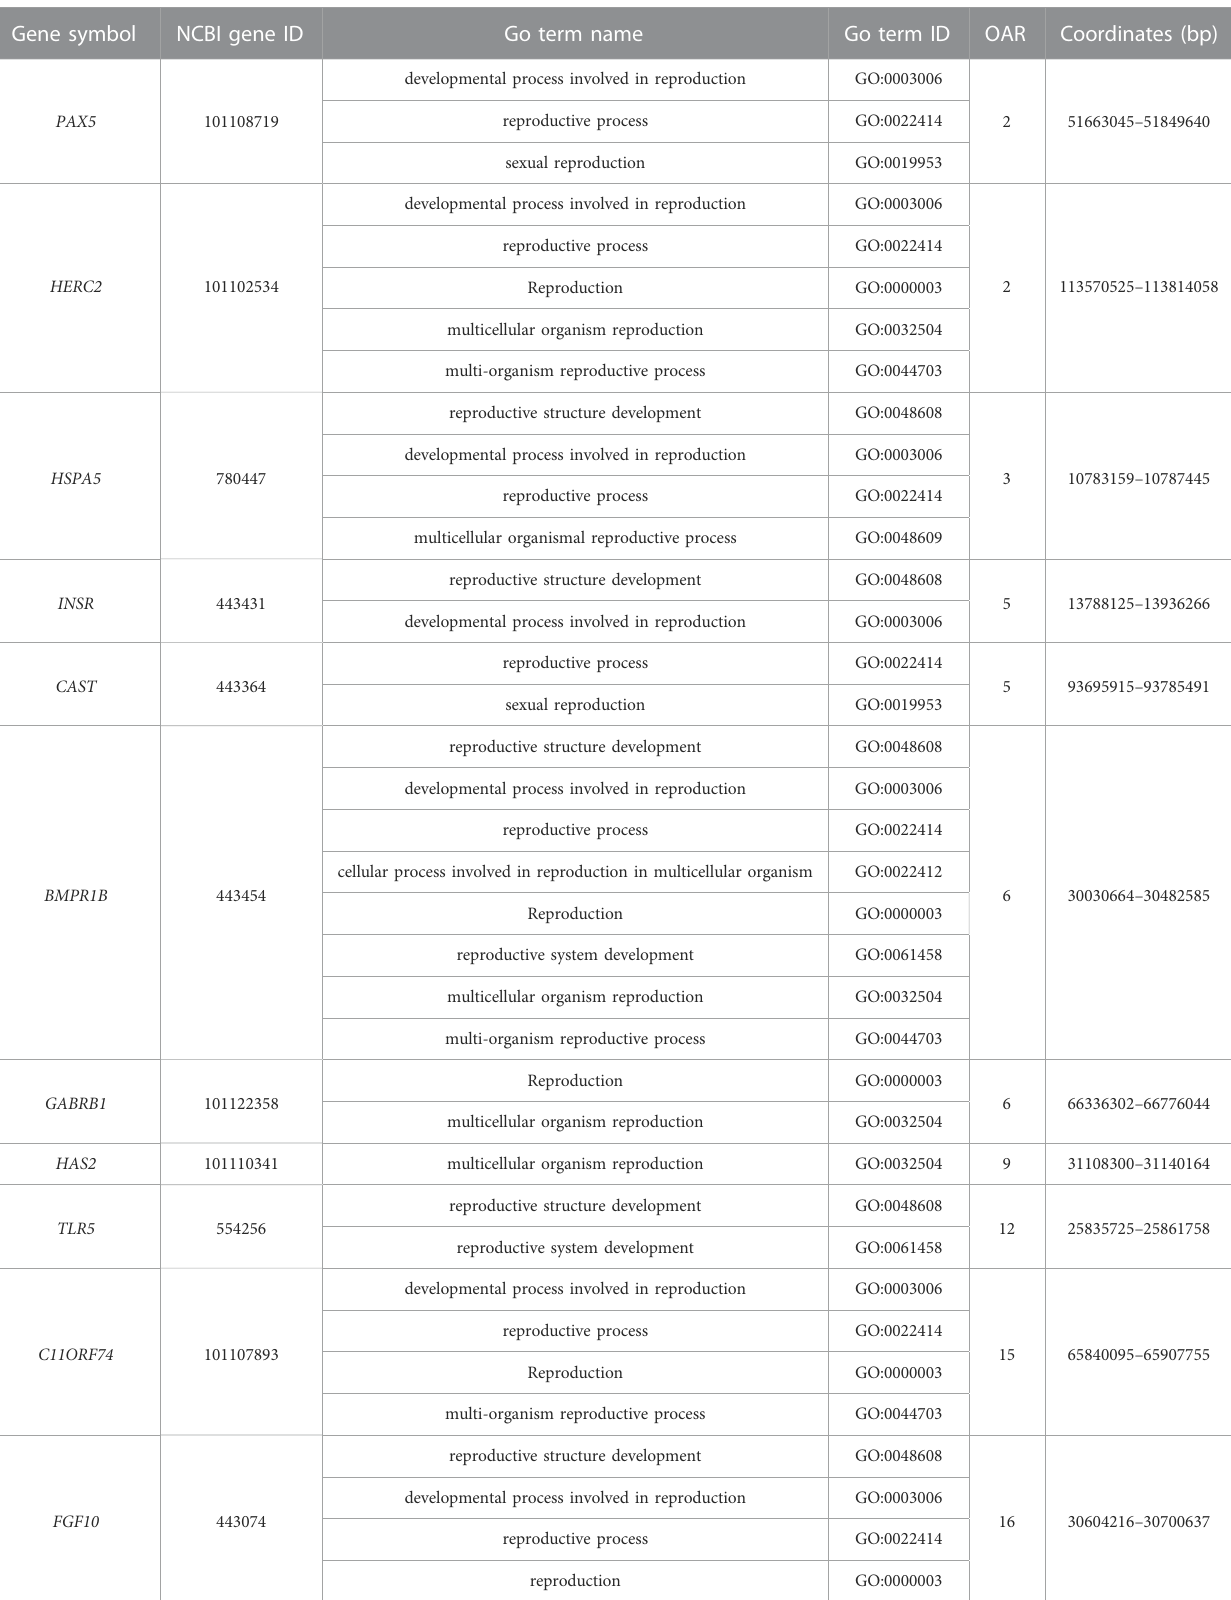
TABLE 2 Candidate genes related to